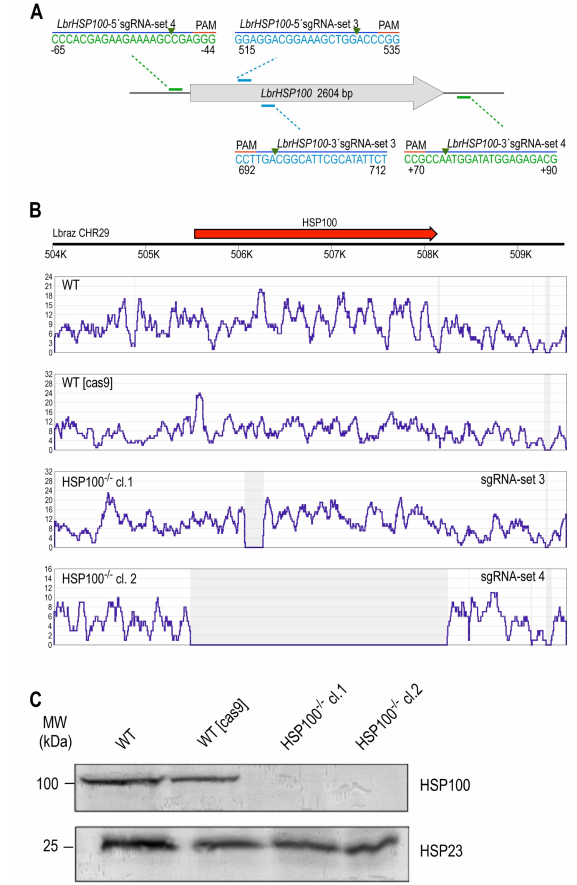
Figure 3. CRISPR–Cas9-mediated disruption of the endogenous HSP100 gene in L. braziliensis. ( A ) For targeting LbrHSP100 (LbrM.29.1350), two sets of sgRNAs tested (set 3 and set 4) worked e ffi ciently. sgRNAs set 3 ( LbrHSP100 -513-5’sgRNA and LbrHSP100 -712-3’sgRNA) targeted disruption of the LbrHSP100 ORF in the N terminus. sgRNAs set 4 targeted 5’ and 3’ non-coding flanking sequences for LbrHSP100 whole-gene deletion. Two cloned L. braziliensis HSP100 – / – lines were studied, HSP100 – / – cl.1 and HSP100 – / – cl.2, derived from transfection of set 3 or set 4 of LbrHSP100 -targeting